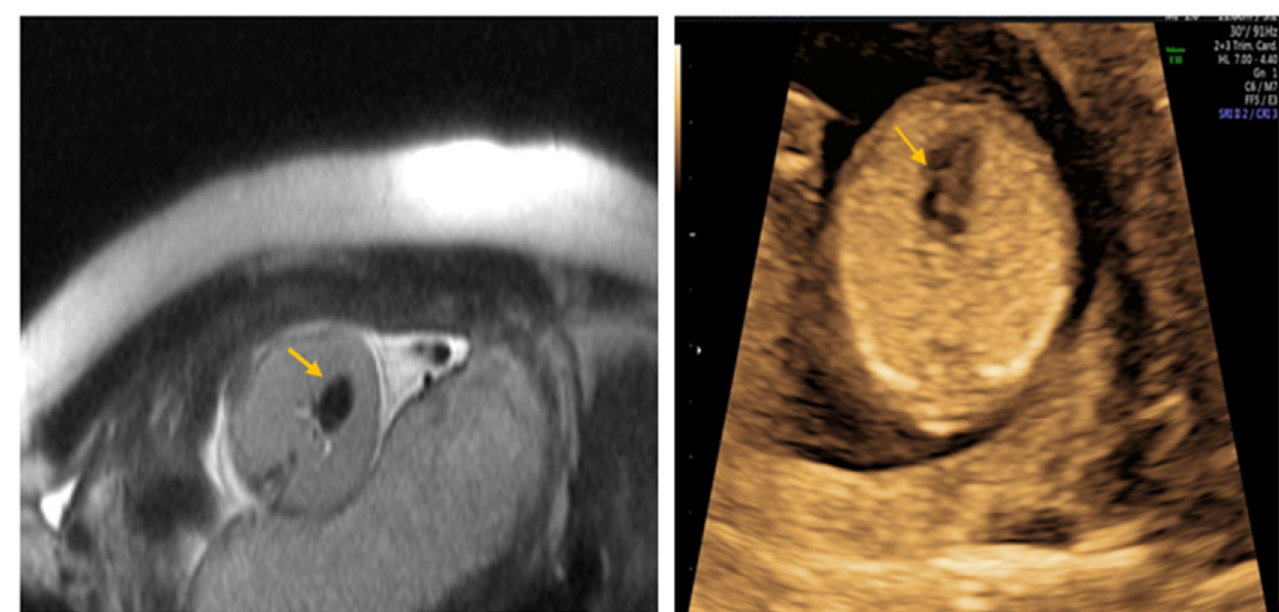
Figure 2. Compressed heart on MRI and ultrasound scan 16 weeks (arrow).